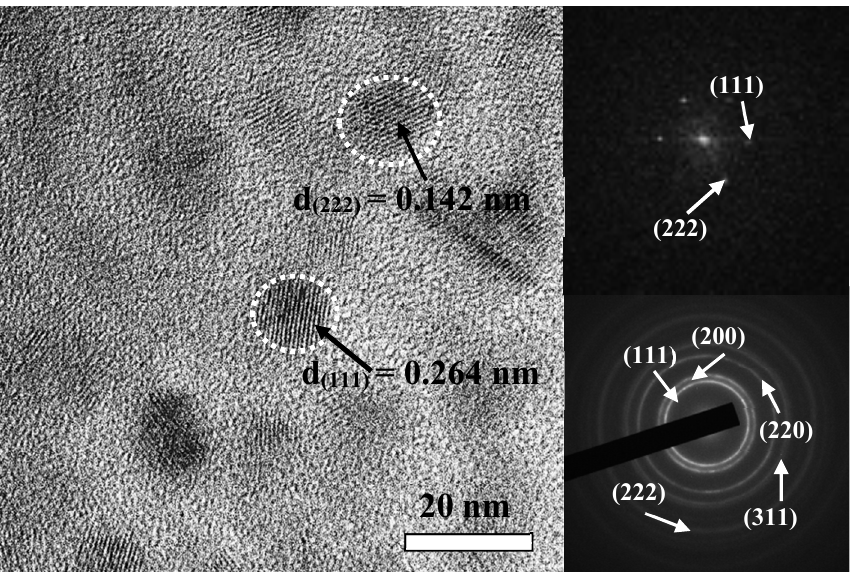
Figure 4. HRTEM image and SAED pattern of HfC coating deposited at a bias voltage of − 200 V.